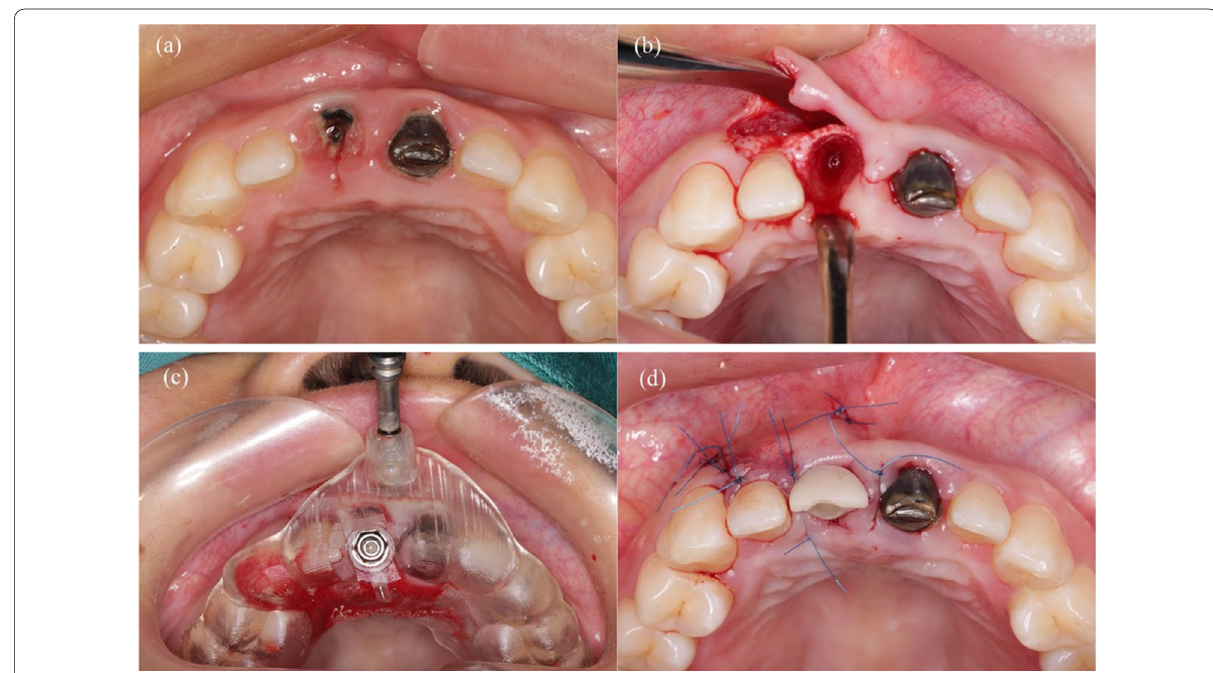
Fig. 2 Surgical procedure for the static CAIS group. a Clinical observation of the hopeless tooth before surgery. b Extraction of 11. c Immediate implant placement with the fully guided static template. d Buccal gap was filled with bone substitute material and pre-fabricated temporary restoration was